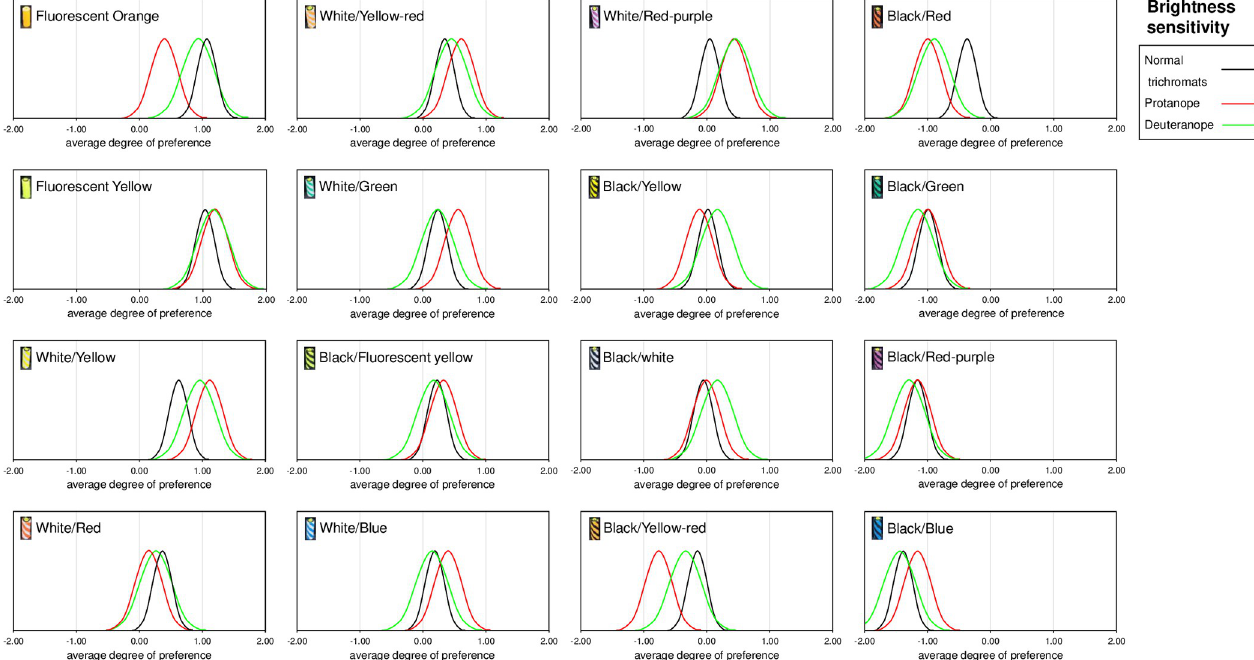
Fig 6. Bell curve of average degree of preference (brightness sensitivity) for normal trichromats and protanope and deuteranope. The average degree of preference for brightness sensation for normal trichromats, protanopes, and deuteranopes is shown in a standard normal distribution for each sample. For fluorescent yellow, the three groups have a high average degree of preference and the bell curves almost overlap. However, in fluorescent orange, the average degree of preference for protanope is lower than the others, and the bell curve is shifted in the negative